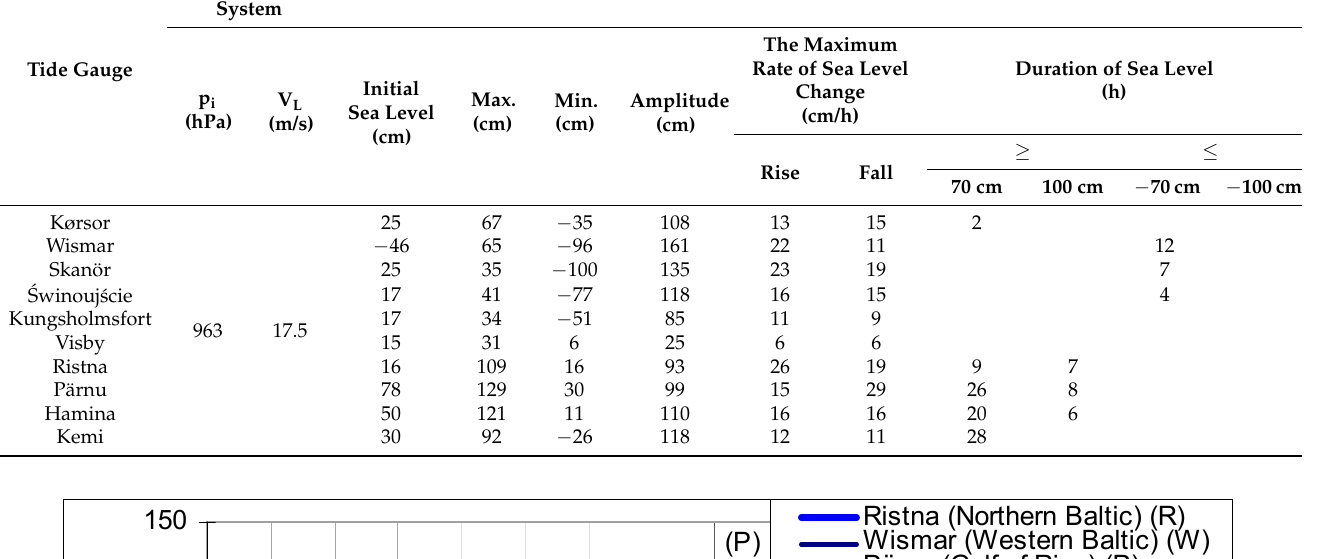
Table 2. Features of the low pressure system and parameters of the storm surge analyzed in the period of 20–23 November 2020. Features of the Low Pressure System Tide Gauge